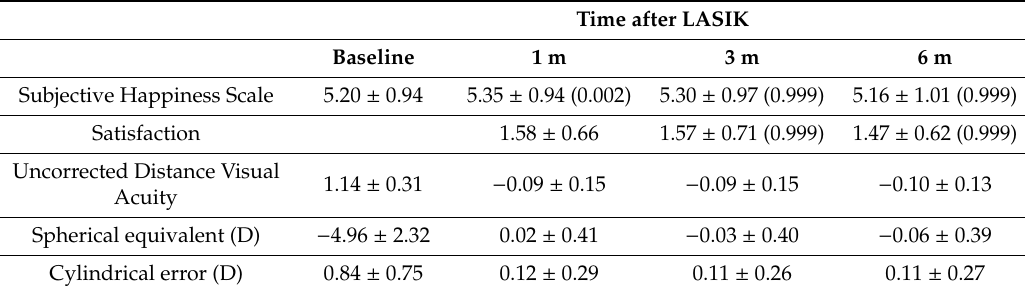
Table 1. Ophthalmological and psychometric